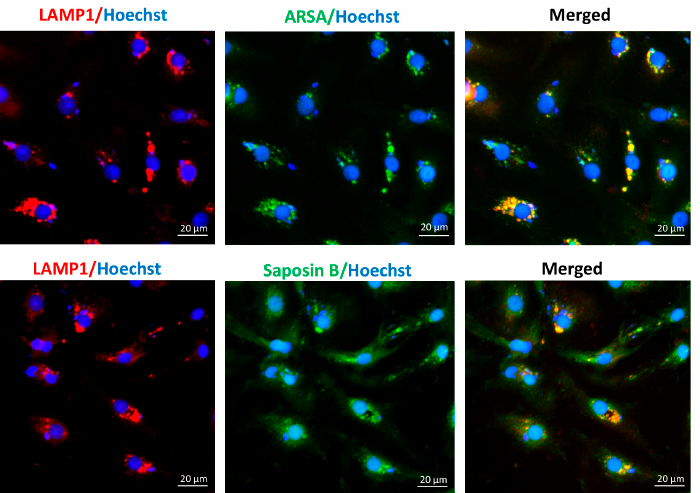
Figure 1. Immunolocalization of ARSA and LAMP1 ( top panel ), and saposin B and LAMP1 ( bottom panel ) in Sertoli cells from 8-month-old WT mice. Left and middle panels show LAMP1 and ARSA or saposin B localization, respectively, whereas the right panels display the merged signals of ARSA with LAMP1 and saposin B with LAMP1. Results shown are representative from three replicate experiments.